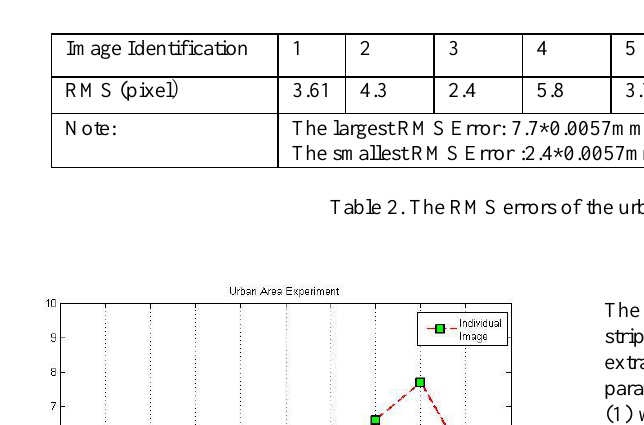
Figure 6. 9 pieces of images stitched together